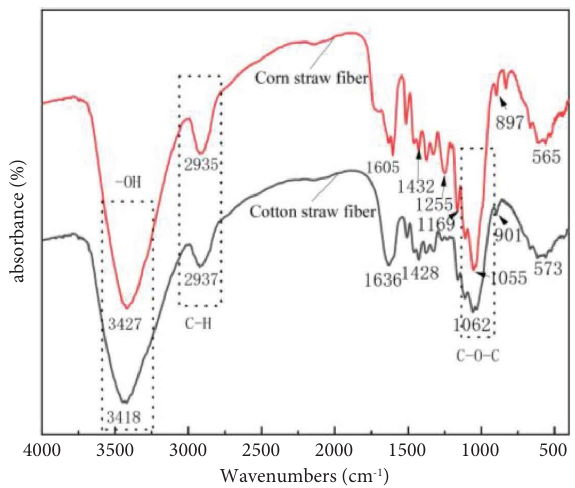
Figure 14: Infrared spectra of straw